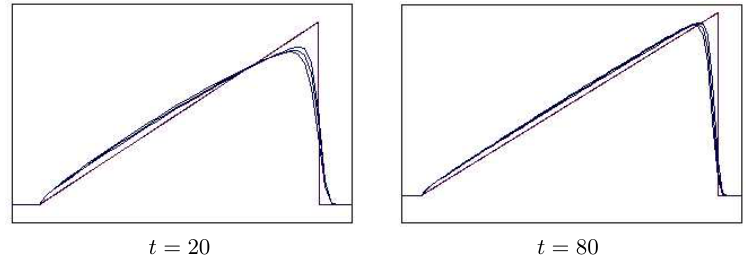
Figure 16. Numerical solution for the Babenko scheme for 5 initial data ( (cid:13) = 0 : 1; 0 : 5; 0 : 9 ).